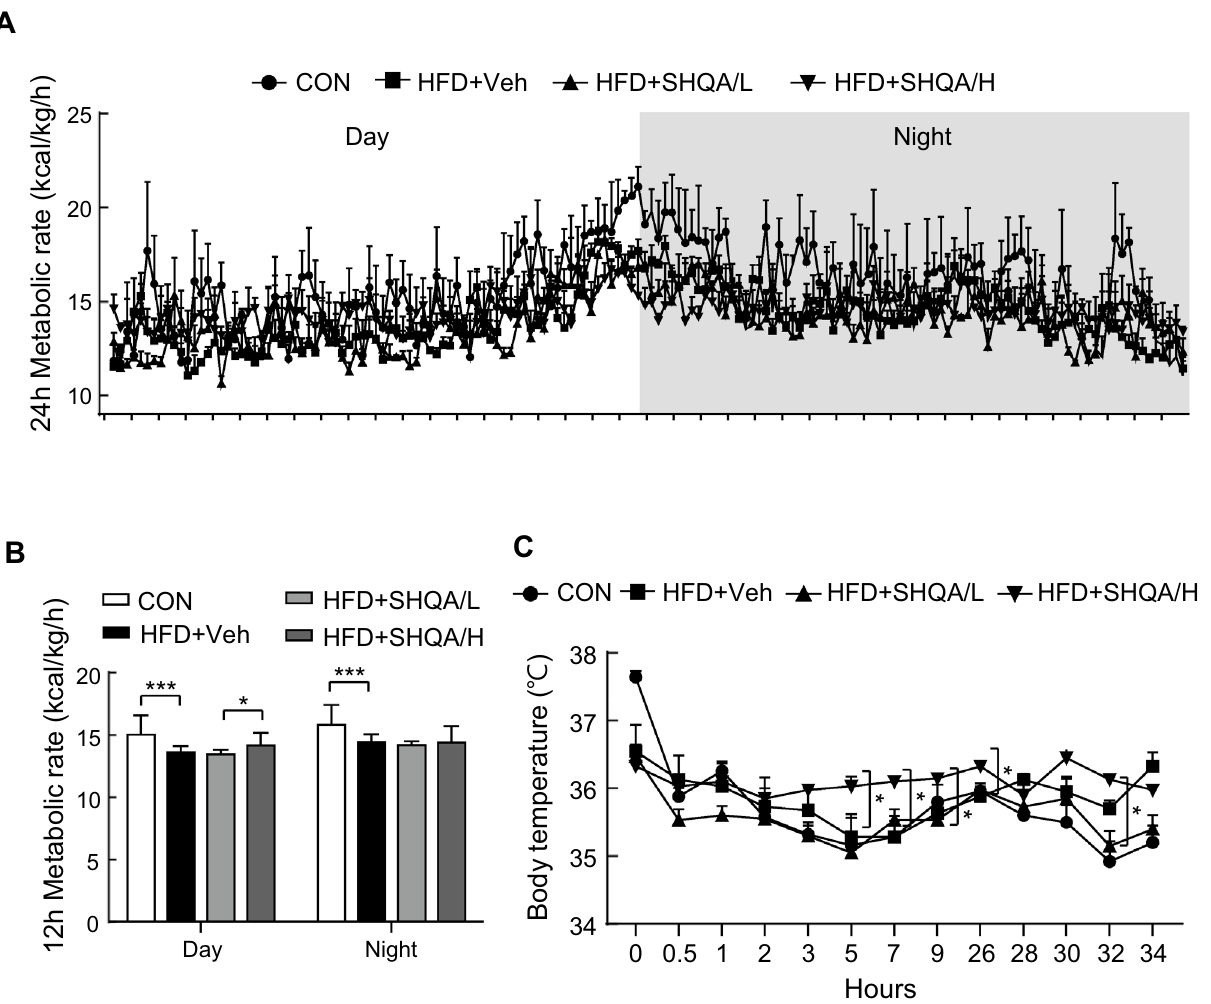
Figure 3. Hypothalamic injection of SHQA elevates energy expenditure and thermogenesis. C57BL/6 mice (4 weeks old) were fed a chow diet (CON) or a HFD with the hypothalamic injection of PBS (CON or HFD + Veh, three times a week), a low dose (HFD + SHQA/L, 20 ng/µl, three times a week) or a high dose of SHQA (HFD + SHQA/H, 100 ng/µl, three times a week) for 12 weeks. Indirect calorimetry was applied to measure the energy expenditure of the mice fed a chow diet or HFD with or without SHQA injection during the light and dark cycle. ( A ) 24 h metabolic rate (kcal/kg/h) was automatically calculated by the machine based on oxygen consumption and carbon dioxide production of mice. ( B ) The values of the metabolic rate were averaged and converted to the bar graphs. ( C ) To investigate adaptive thermogenesis, a rectal thermometer was applied to mice fed a chow diet or HFD with or without SHQA injection and the temperature was recorded in a cold room at 4 °C for 34 h. Data are expressed as mean ± S.E.M. (n = 6–7). Statistical differences between CON, HFD + Veh, HFD + SHQA/L (SHQA, 20 ng/µl), and HFD + SHQA/H (SHQA, 100 ng/µl) were determined using one-way ANOVA followed by the Tukey’s post hoc test: * p < 0.05, *** p <